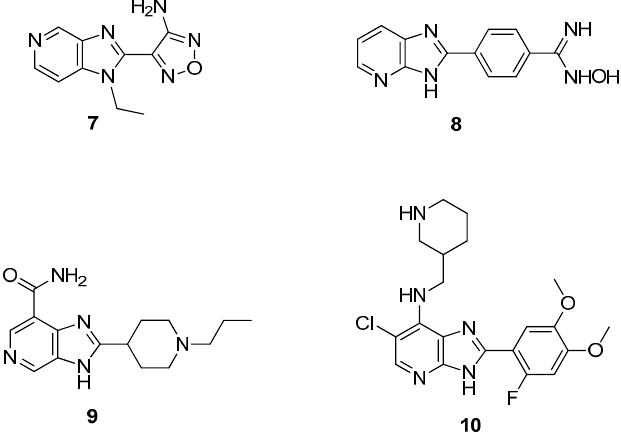
Figure 4. Azolopyridines with antiproliferative activity.